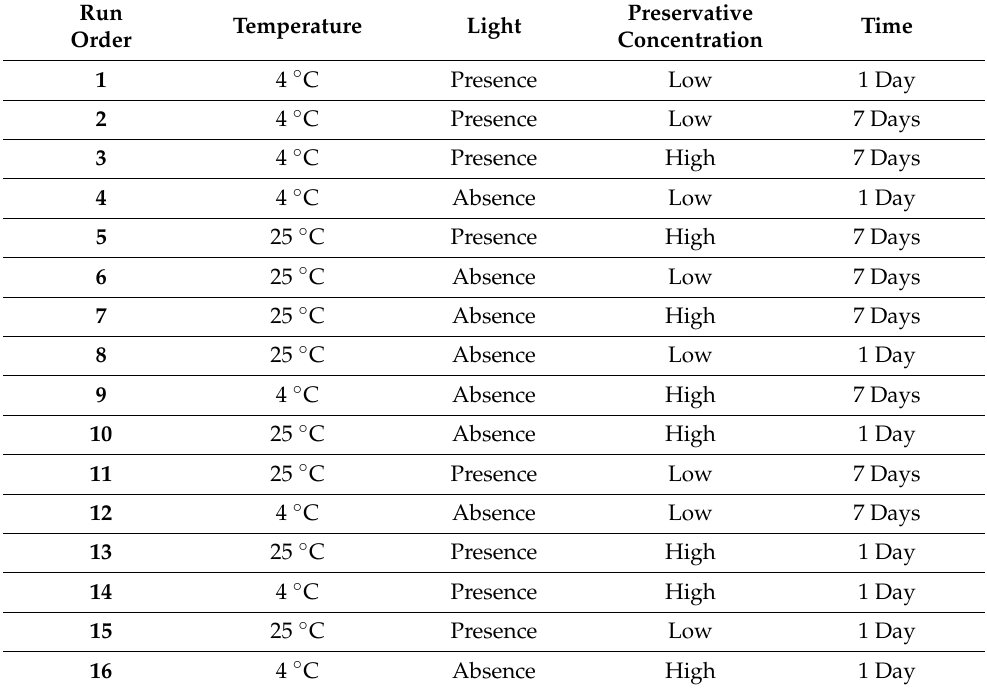
Table 5. Experimental design matrix with four factors at two levels (2 4